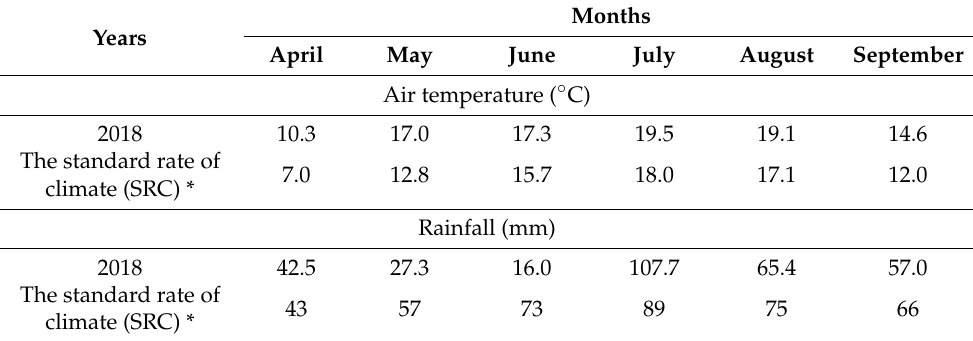
Table 1. Air temperature and rainfall during the potato growing season in